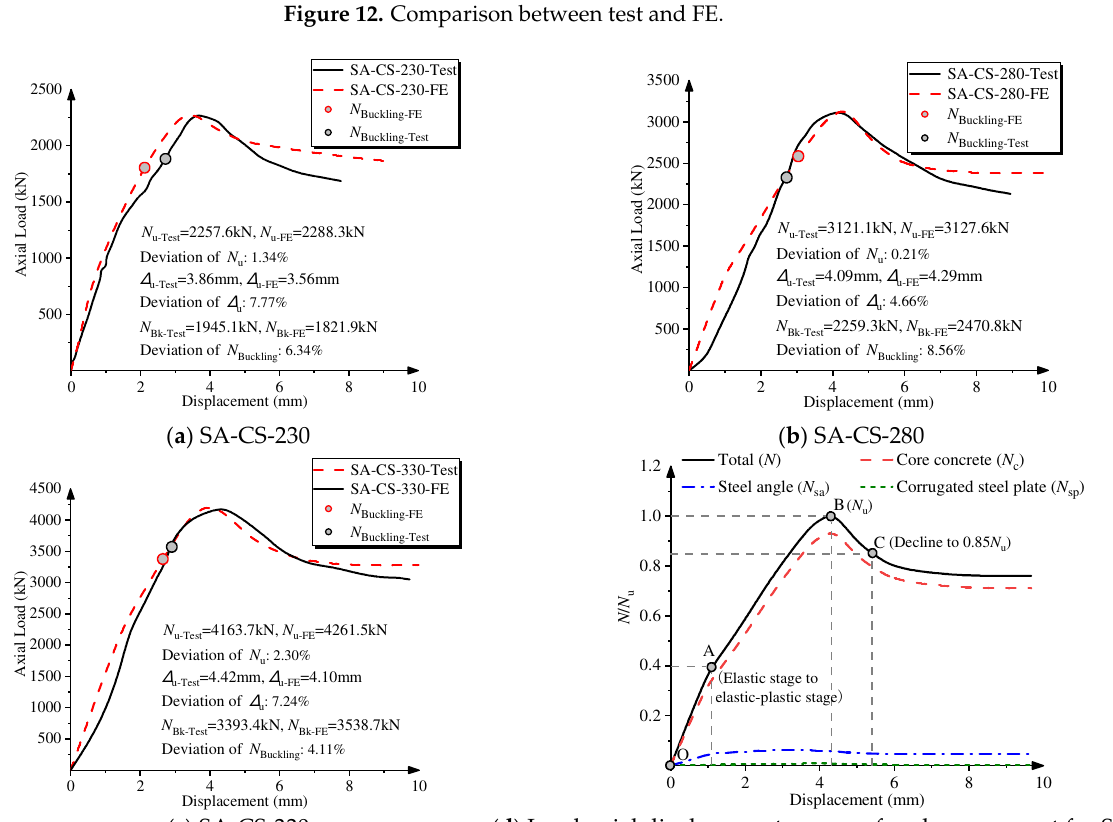
Figure 13. Comparison of FE and test load–axial displacement curves.